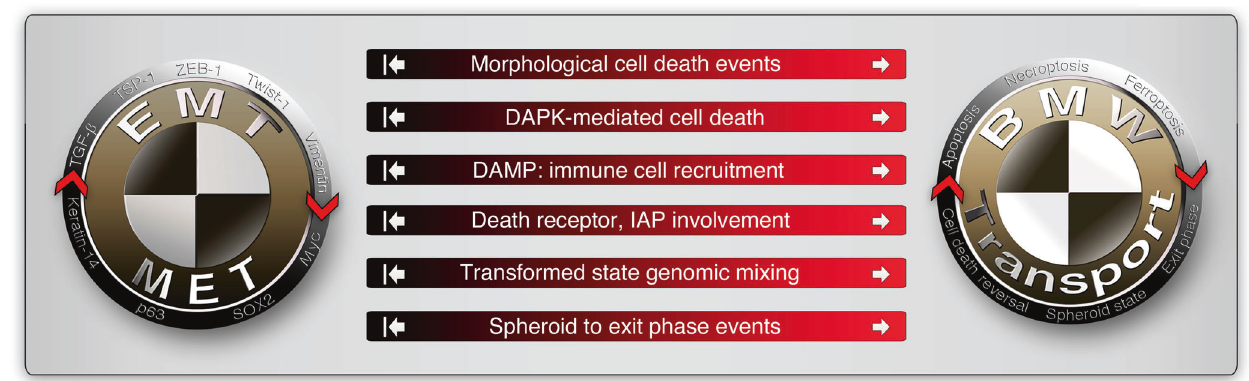
Fig. 6 Differences between EMT and BMW pathways of metastasis. The non-exhaustive signatures that discriminate EMT and BMW pathways are illustrated. The white arrows on the red side of the horizontal bars indicate that these events are involved in the BMW pathway of metastasis. The white inhibited arrows on the black side of horizontal bars indicate, that these events are less or not at all involved in the EMT pathway of metastasis. Note that these events may happen in a non-metastatic context in both pathways. DAPK death-activated protein kinase, IAP inhibitor of apoptotic proteins (c-IAPs-1/2, XIAP), DAMP damage-associated molecular